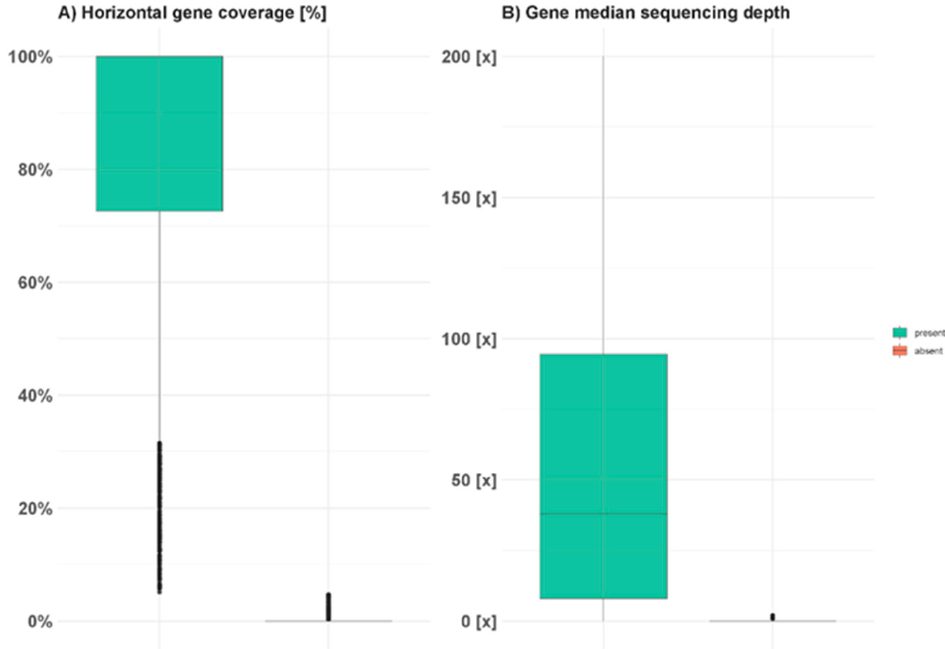
Figure 3. Statistics of rye 7RS genes present and absent on Triticale 380SD 7RS. ( A ) Horizontal gene coverage of bases within the coding gene region of genes on the short arm of rye chromosome 7. ( B ) Median sequencing depth of the coding regions of genes on the short arm of rye chromosome 7.